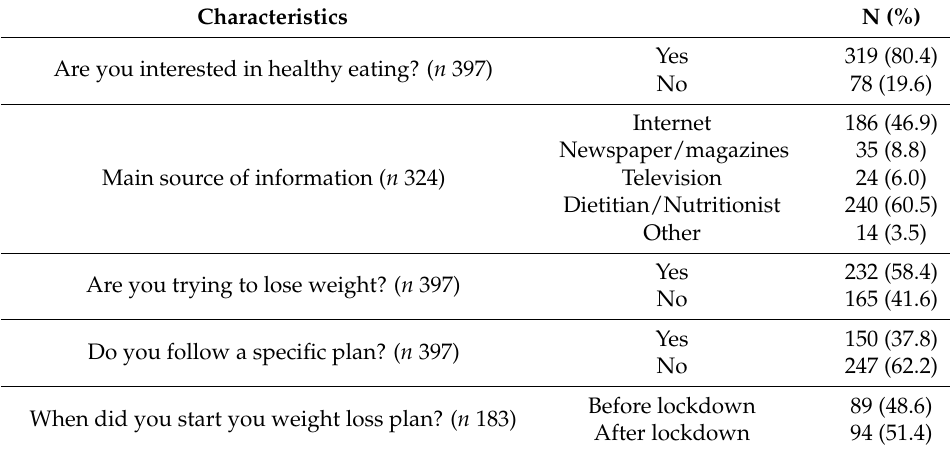
Table 5. Interest in healthy eating and weight loss